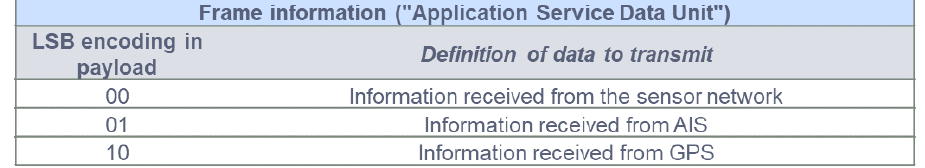
Figure 22. Coding in IEEE 802.11ac payload the services provided.